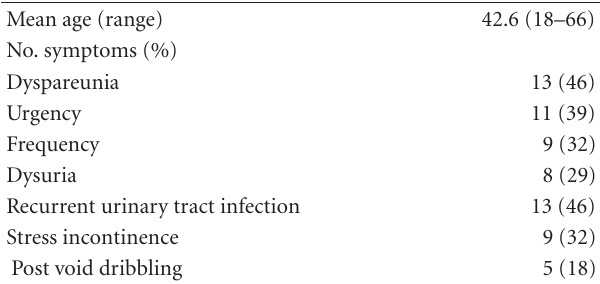
Table 1: Patient characteristics.